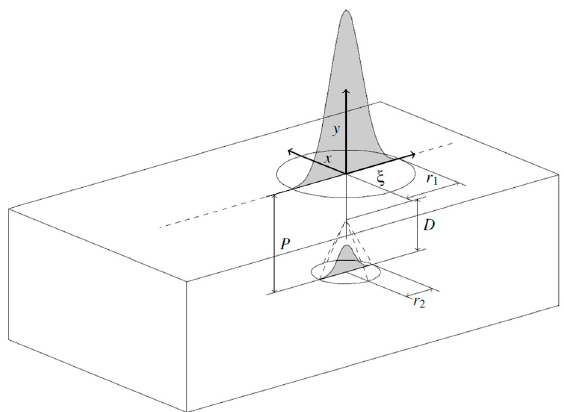
Figure 8. Combined heat source model with geometrical parameters as proposed in the work of [46]. P = placement of the cone. D = depth of the cone. r 1 and r 2 are the radii of Gaussian and cone heat sources, respectively.